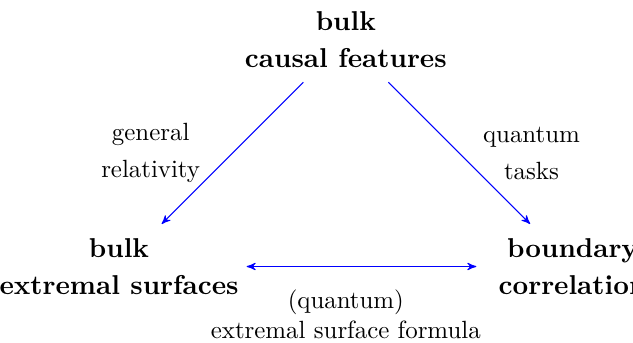
Figure 3. The expanded geometry-correlation connection present in